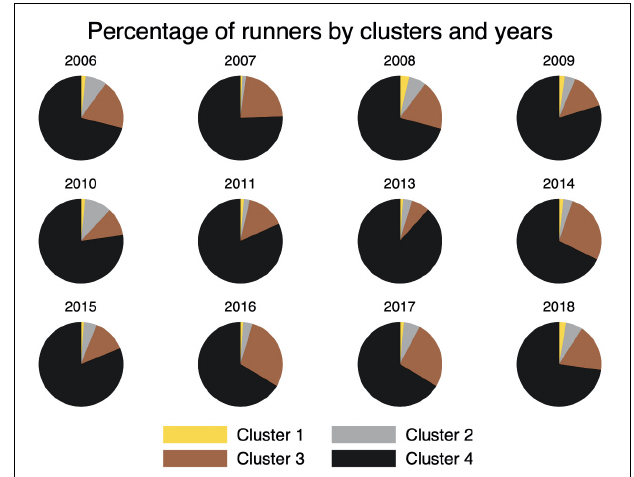
FIGURE 1 | Percentage of runners by clusters and